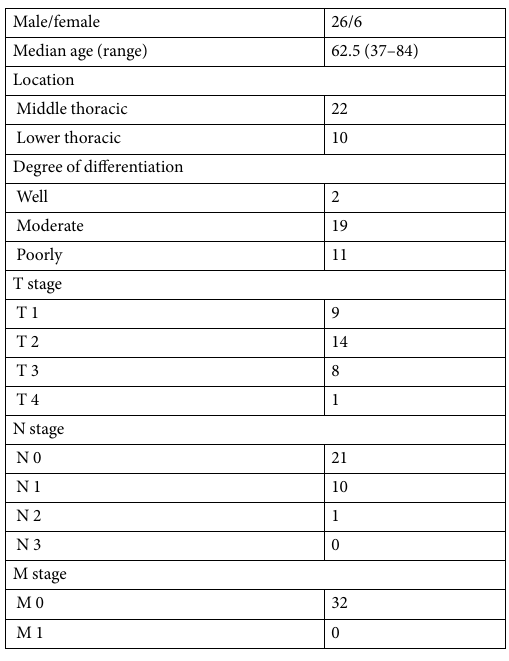
Table 3. Patient demographics and clinical information.